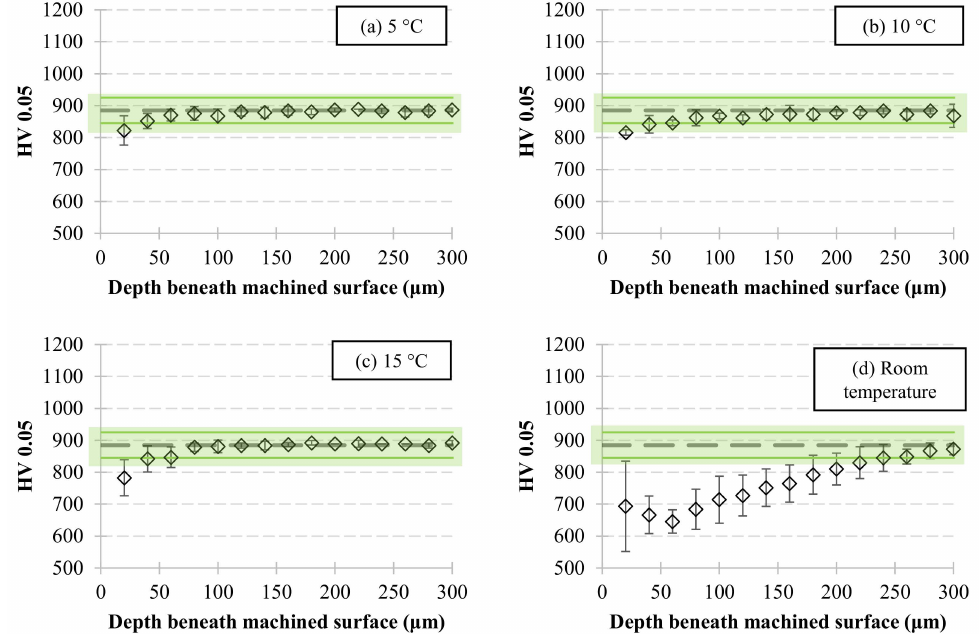
Figure 5. Microhardness as a function of depth beneath the machined surface after grinding with the cutting fluid applied at different temperatures: ( a ) 5 ◦ C; ( b ) 10 ◦ C; ( c ) 15 ◦ C; and ( d ) room